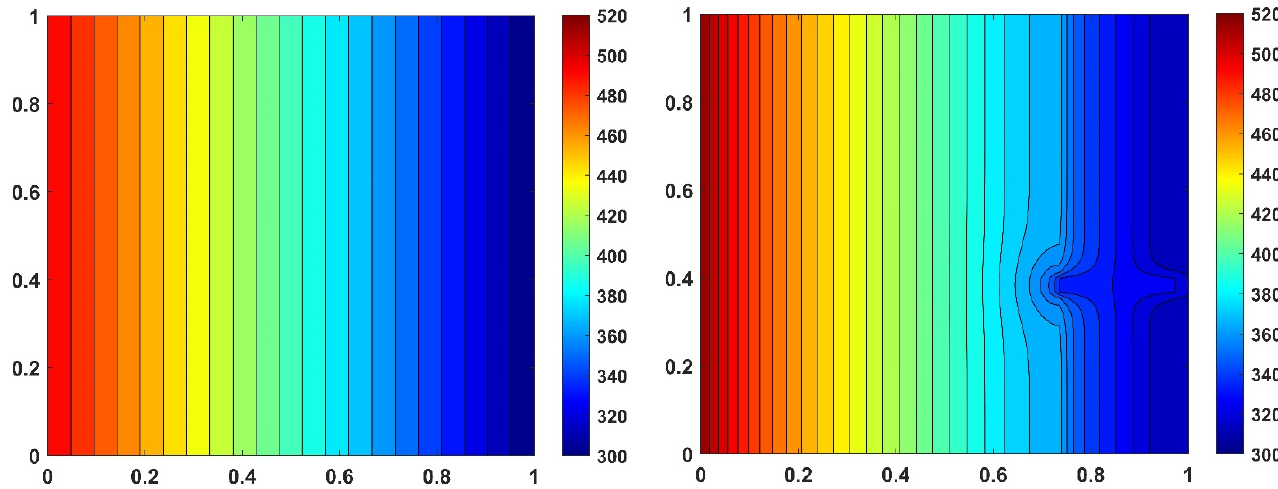
Figure 19. The maximum errors as a function of the h for Experiment 9 in the case of convection and radiation with high-temperature boundary conditions.